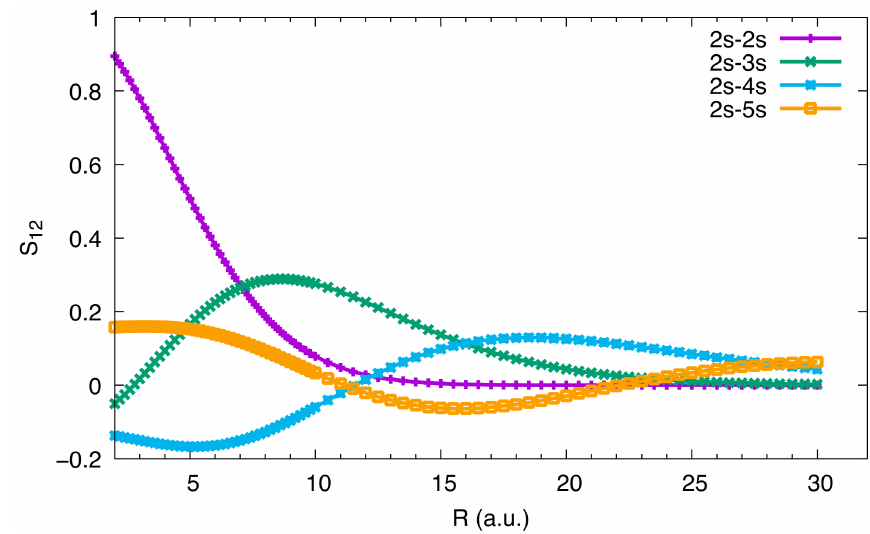
Figure 5. Overlap integrals between ns and 2s atomic orbitals as functions of